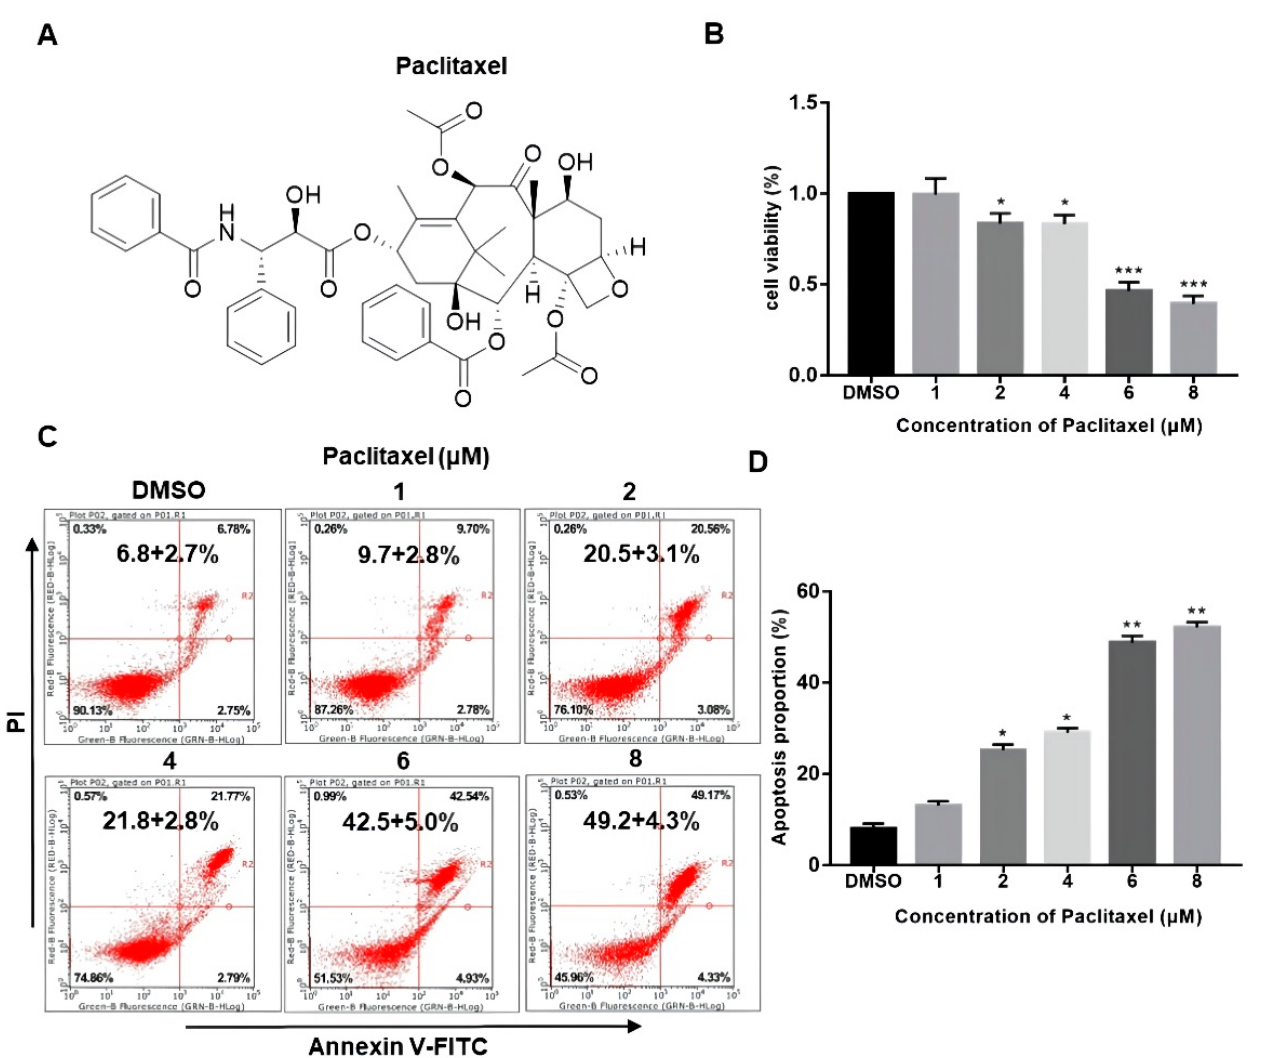
Figure 1. Paclitaxel inhibited the viability and promoted the apoptosis of PC3M cells. ( A ) The chemical structure of paclitaxel. ( B ) Cell viability of PC3M cells after treatment with different concentrations of paclitaxel. ( C ) PC3M cells were treated with paclitaxel (2 µ M) for 24 h and stained with annexin V-FITC and propidium iodide and then analyzed by flow cytometry. ( D ) The percentage of apoptotic cells in each treatment were analyzed statistically and presented in the form of bar graphs in three independent experiments. Results are expressed as mean ± SD, n = 3. *: p < 0.01, **: p < 0.05, ***: p < 0.001.